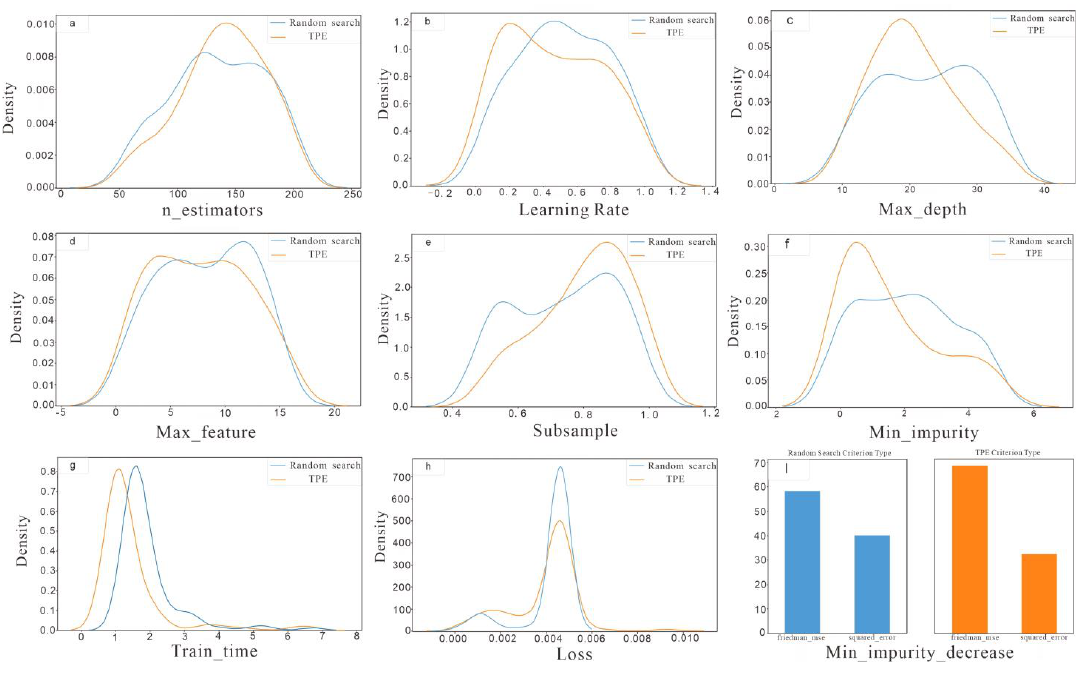
Figure 6. The kernel density map of parameter optimization based on random search and TPE on the test sets (iteration = 100).( a – i ) the parameter of n_estimators, learning rate, max_depth, max_feature, subsample, min_impurity, train_time, loss, min_impurity_decrease.